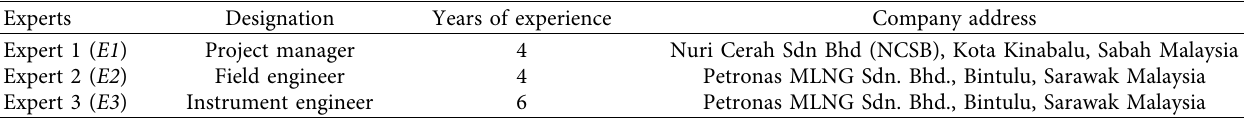
Table 1: Biographical data of experts.